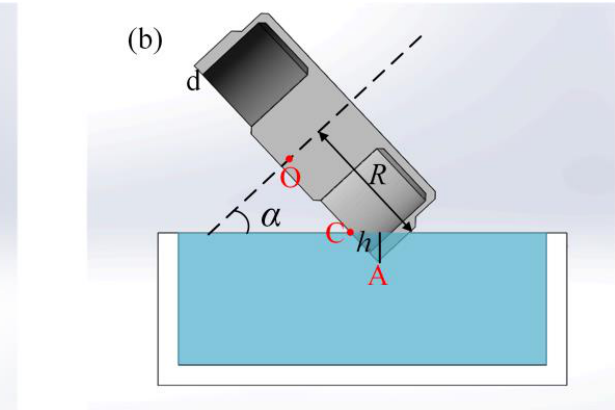
where v is the etching rate of the hydrofluoric acid on fused silica in µ m/min, C 0 ( α , β ), C 2 ( α , β ), C 4 ( α , β ) are the coefficients of Fourier series given in [30], and the coefficients higher than four is omitted in this case. As Equation (9) suggests, the removal of the second harmonic error could lead to the variation of the fourth harmonic error. However, it is possible to select the inclined angle α and the included angle β such that C 4 ( α , β ) = 0. Under this condition, the existing fourth harmonic error is immune to the balance of the second harmonic error. The desired parameters α , β lie on the intersecting lines of the zero-value surface in blue and the curved surface in red, as shown in Figure 8. There are three intersecting lines with numerous combinations of α and β . The larger angle β means the deeper immersed depth during chemical balancing, and the larger inclined angle α means that the resonator is more perpendicular to the liquid level. Taking both the experimental apparatus and the resonator structure into consideration, the angle α , β is finally set as 1.22 rad and 1.05 rad, which is marked green in Figure